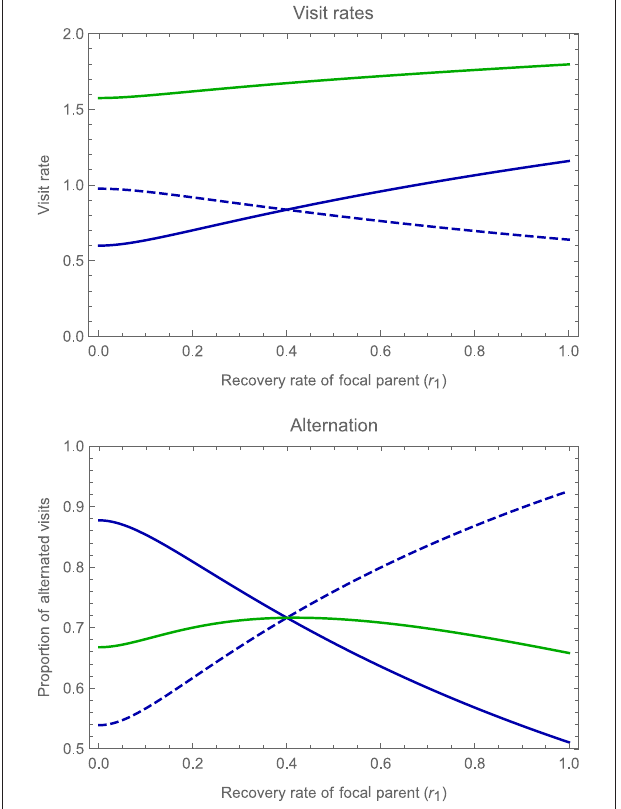
FIGURE 8 | Changes in the stable alternating strategy (upper panel), and in overall mean visit rates (lower panel), as one varies a focal parent’s probability of detecting its partner’s visits ( d 1 ), while holding the latter’s probability of detection d 2 constant at a value of 0.5. In the upper panel, solid curves show the visit rates of the focal parent, λ 1 (immediately after it detects a visit by its partner) in blue and µ 1 (immediately after visiting the young itself) in red, while dashed curves show the corresponding visit rates of the partner, λ 2 in blue and µ 2 in red. In the lower panel, the solid blue curve shows the mean visit rate of the focal parent and the dashed blue curve the mean visit rate of its partner, while the green curve shows the total mean visit rate by the pair. Payoffs are as specified in the legend to Figure 6 , with other parameter values r 1 = r 2 = 0.4 and h =